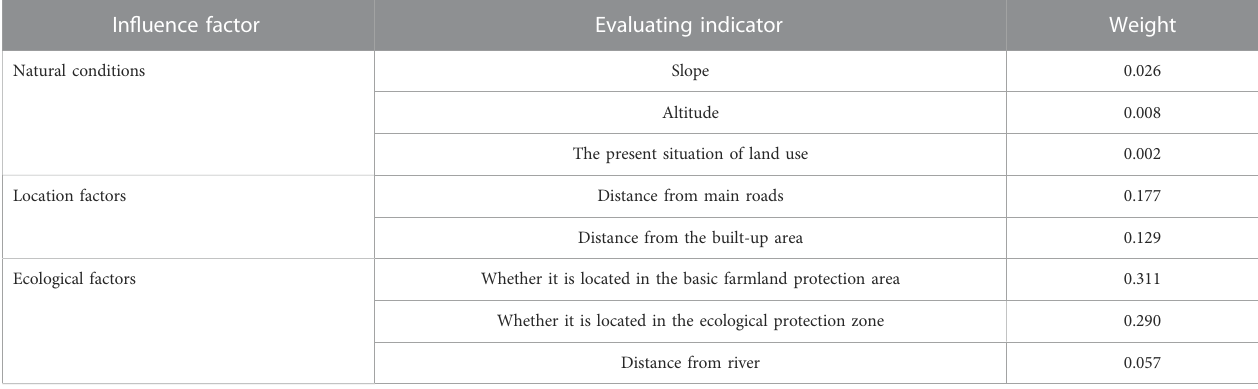
TABLE 1 Evaluation index of suitability for spatial expansion of construction